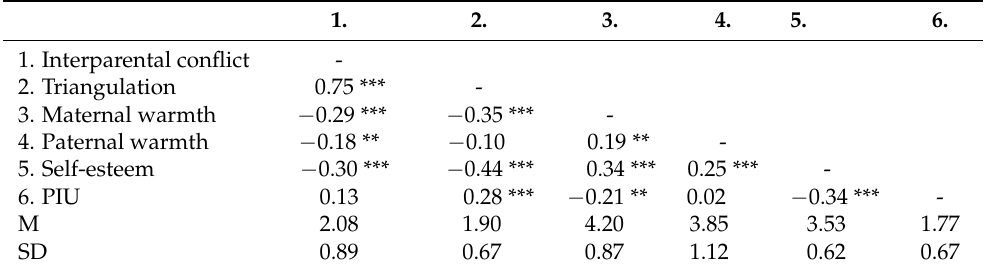
Table 2. Correlations, means, and standard deviations of the study variables.